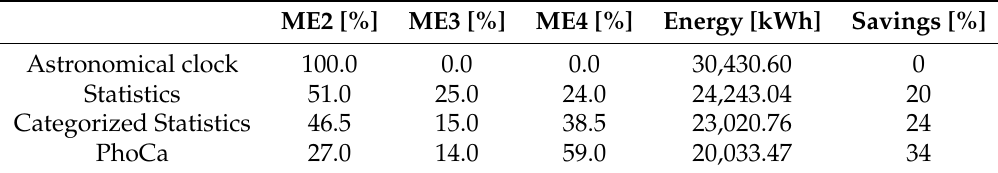
Table 1. Lighting class change based control, comparison of different